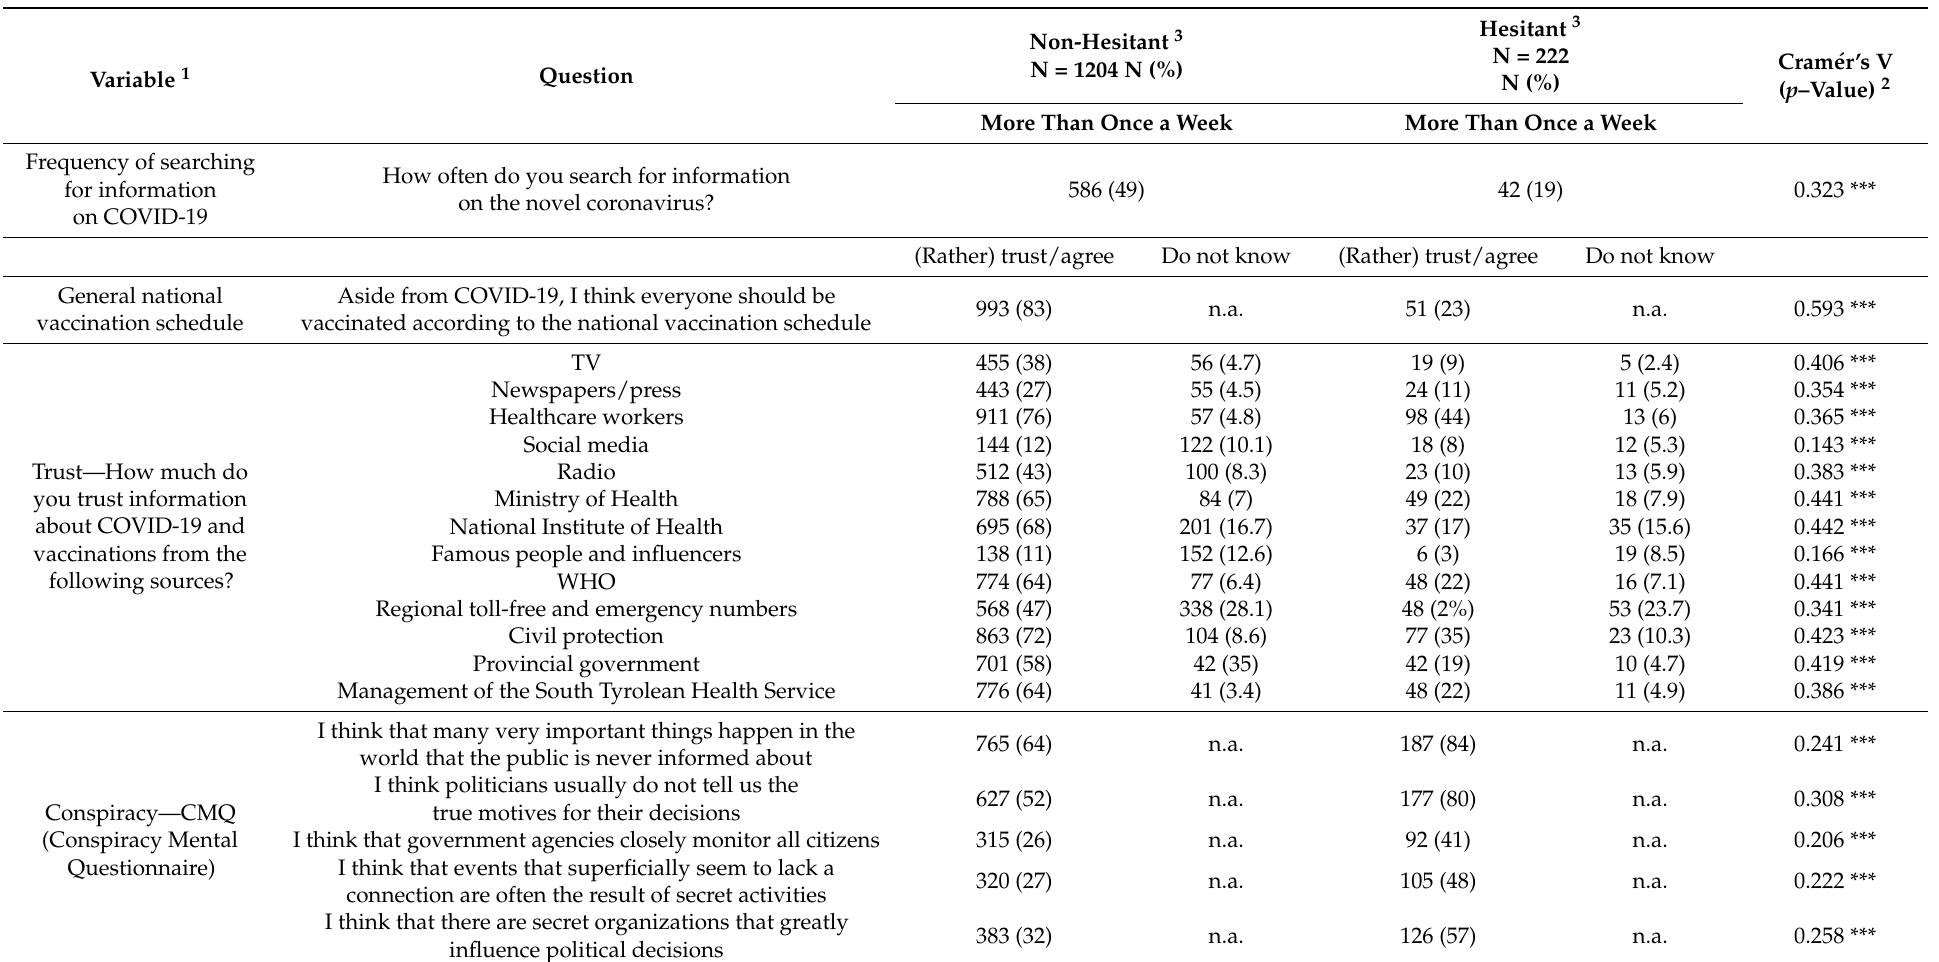
Table 3. Variables related to vaccine hesitancy and the effects of linguistic group membership in South Tyrol,